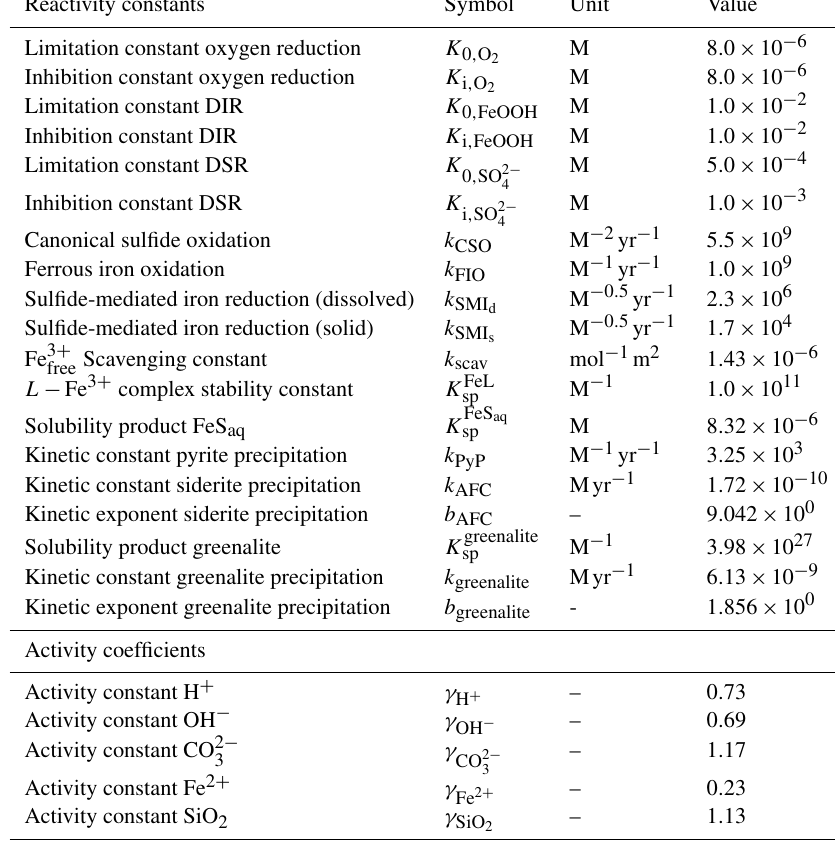
Table A1. List of kinetic constants for the reactions included in the cGENIE model – converted to cGEnIE units. Reactivity constants Symbol Unit Value Limitation constant oxygen reduction